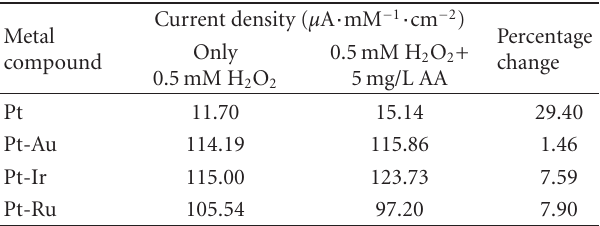
Table 2: Comparison of oxidation current change at 0.5mM H 2 O 2 detection with a presence of